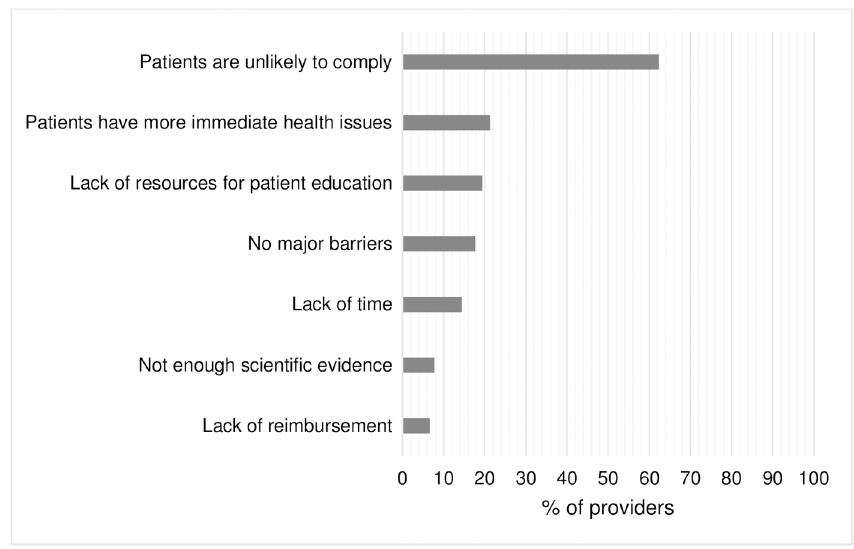
Fig 1. "What is your biggest barrier to reduce dietary sodium intake with hypertensive or pre- hypertensive patients? Select all that apply"—DocStyles 2015.